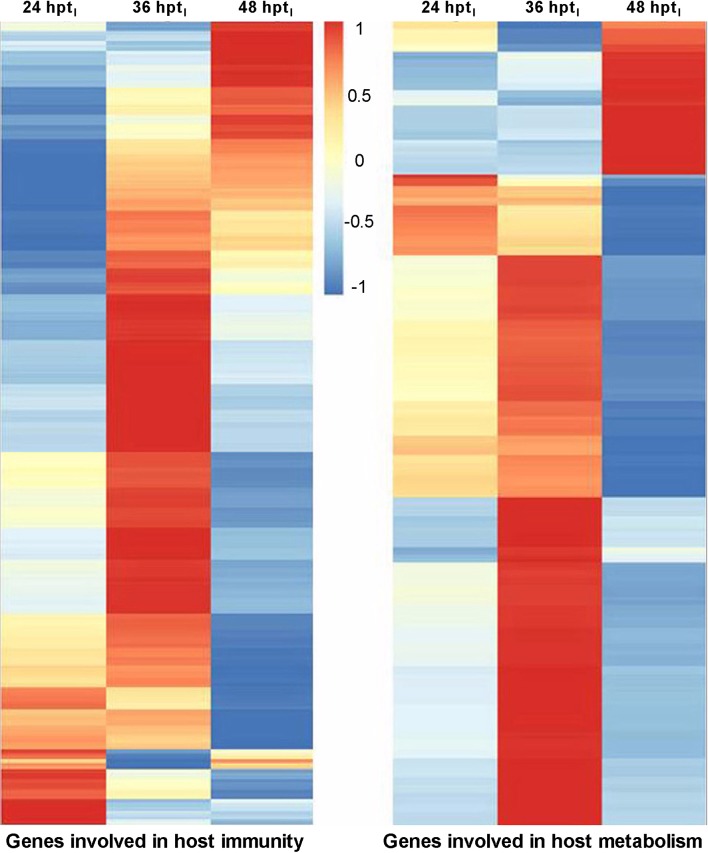
Heatmap for the distribution of P. xylostella immunity- and metabolism-related genes expressed at 24, 36 and 48 h after the B. bassiana infection.Scale bar: Gene expression level in the fungal treatment versus control.